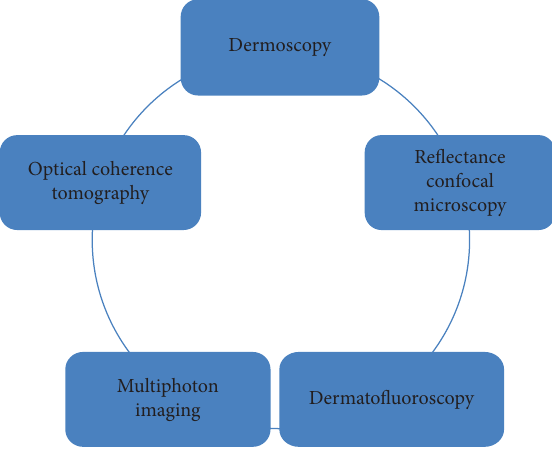
Figure 1: Noninvasive optical technologies for skin cancer